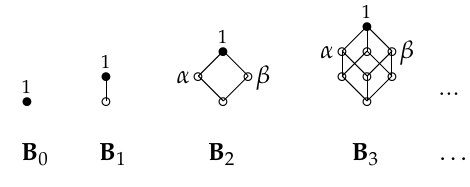
Figure 1. Boolean matrices.